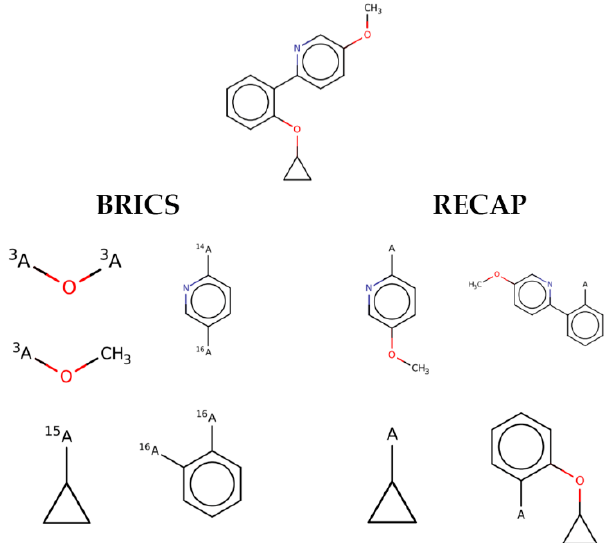
Figure 2. An example of the differences in the fragments generated by BRICS vs RECAPS. Note that, in contrast to RECAPS, the ends of the fragments generated by BRICS are marked with an isotopic label.